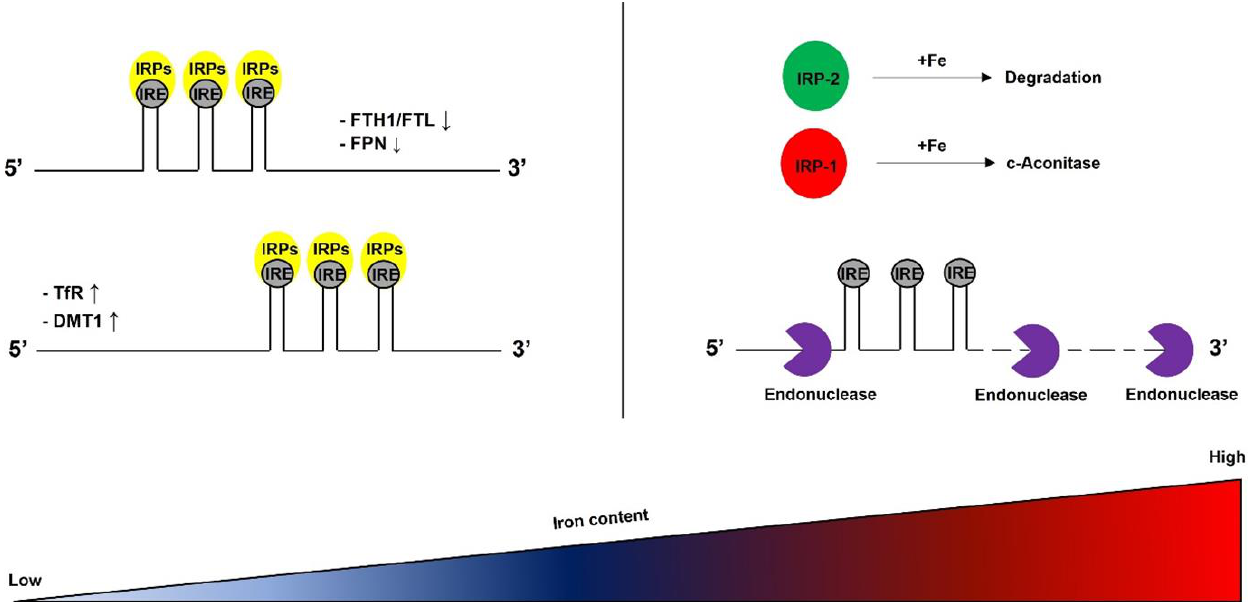
Figure 1. The IRP/IRE system. IRPs consist of two proteins, IRP1 and IRP2. Under iron-rich conditions, iron forms iron–sulfur clusters. Iron–sulfur clusters bind to IRP1. IRP1 acts as c-aconitase. Additionally, iron–sulfur clusters bind to FBXL5 (not described) and mediate IRP2 ubiquitination- dependent degradation. Eventually, inhibition of IRPs leads to the degradation of iron uptake-related mRNAs by the endonuclease. By contrast, under iron shortage conditions, IRPs bind to the IRE within mRNA. This stabilizes the mRNAs or prevents their translation in the nucleus. DMT1, divalent metal transporter 1; FPN1, ferroportin 1; FTH1, ferritin heavy chain; FTL, ferritin light chain; IRE, iron-responsive element; IRP, iron-regulatory protein; IRP1, iron-regulatory protein 1; IRP2, iron-regulatory protein 2; Tfr, transferrin